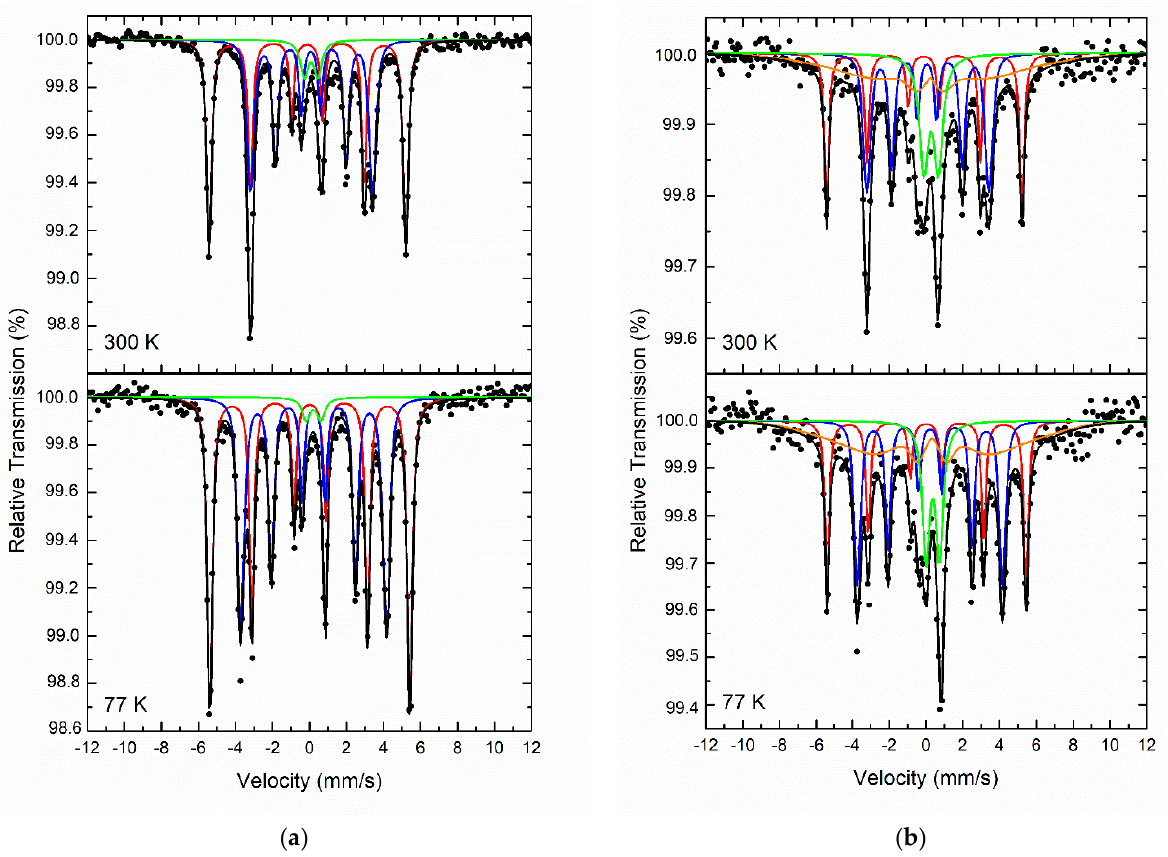
Figure 11. 57 Fe Mössbauer spectra of mAC-snack before ( a ) and after ( b ) 48 h reaction with 5.24 ppm Cr(VI) solution, recorded at 300 and 77 K. Table 7. Mössbauer hyperfine parameters resulting from the best fits of the corresponding spectra of mAC-snack before and after 48 h reaction with 6 ppm Cr(VI) solution recorded at 300 and 77 K. IS is the isomer shift (given relative to α - Fe at 300 K), Γ/2 is the half line - width, 2ε and QS are the quadrupole shift and quadrupole splitting respectively, B hf is the central value of the hyperfine mag- netic field, ΔB hf is the spreading of B hf , and Area is the relative spectral absorption area of each com- ponent used to fit each spectrum. Typical errors are ± 0.02 mm/s for IS, Γ/2, and 2ε, ± 3 kOe for B hf and ± 5% for Area.